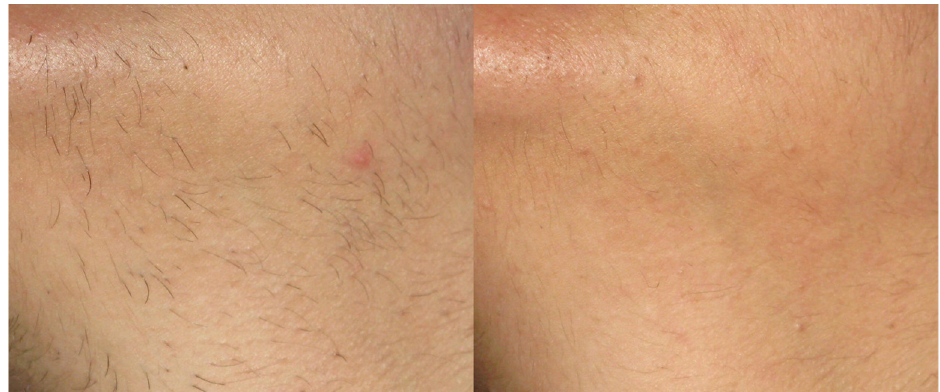
Figure 3. Patient 1’s right side treated with the new “in-motion” technique. No di ff erence is noted in the results when compared to that of the standard technique.